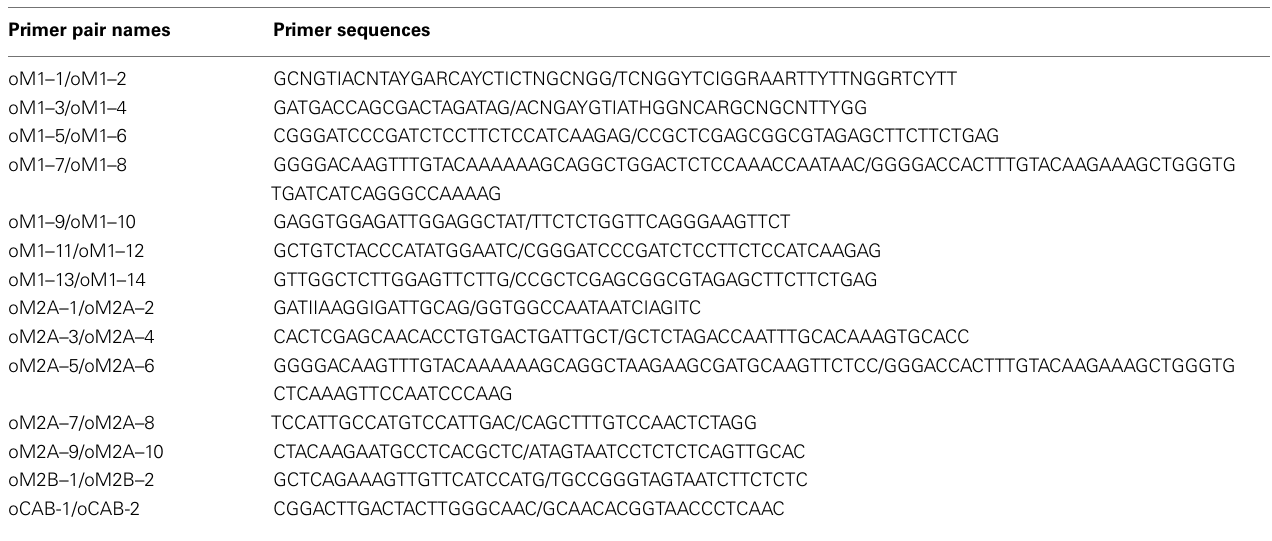
Table 1 | DNA primer pairs used in this